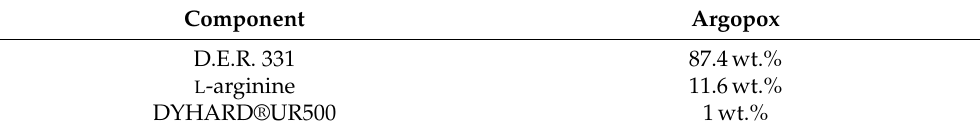
Table 1. Composition of